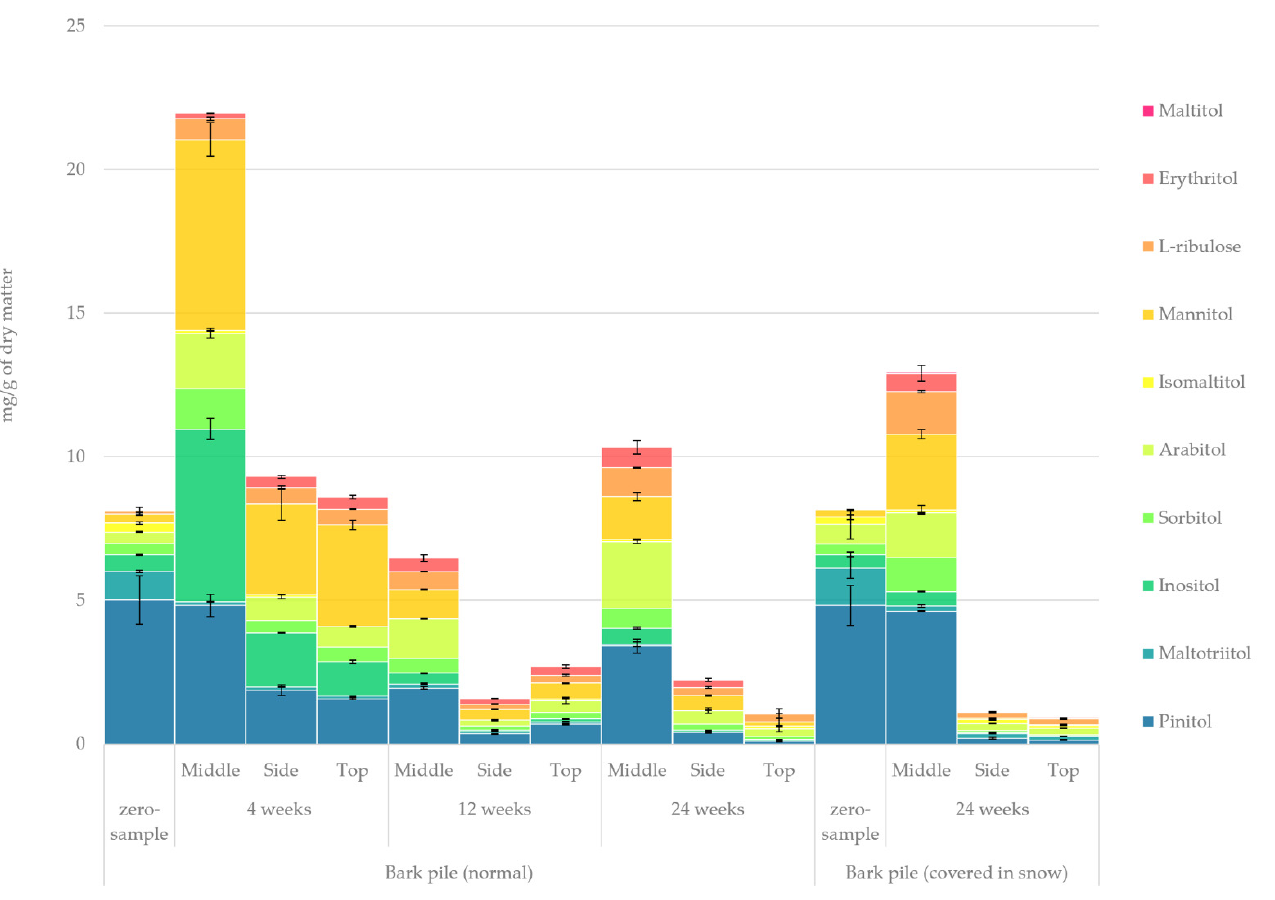
Figure 10. Quantified amounts of individual sugar alcohols in the hydrophilic extracts of stored